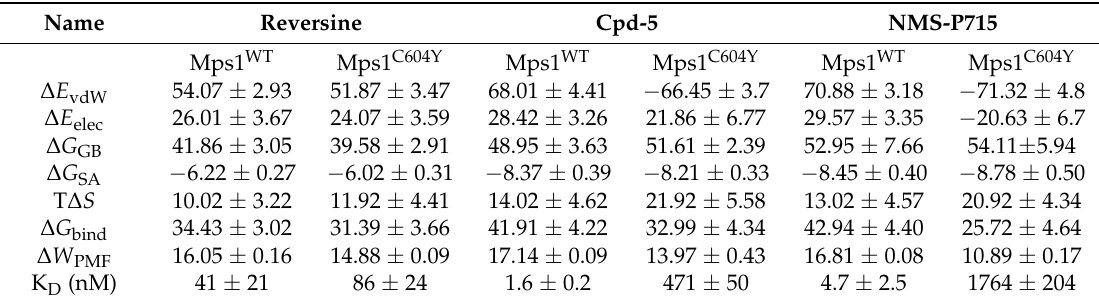
Table 1. Energy terms of reversine, Cpd-5 and NMS-P715 towards Mps1 WT and Mps1 C604Y